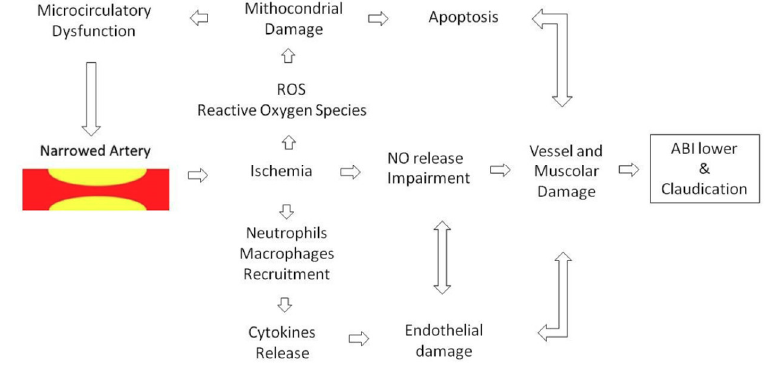
Figure 2. Pathophysiology of peripheral arterial disease.